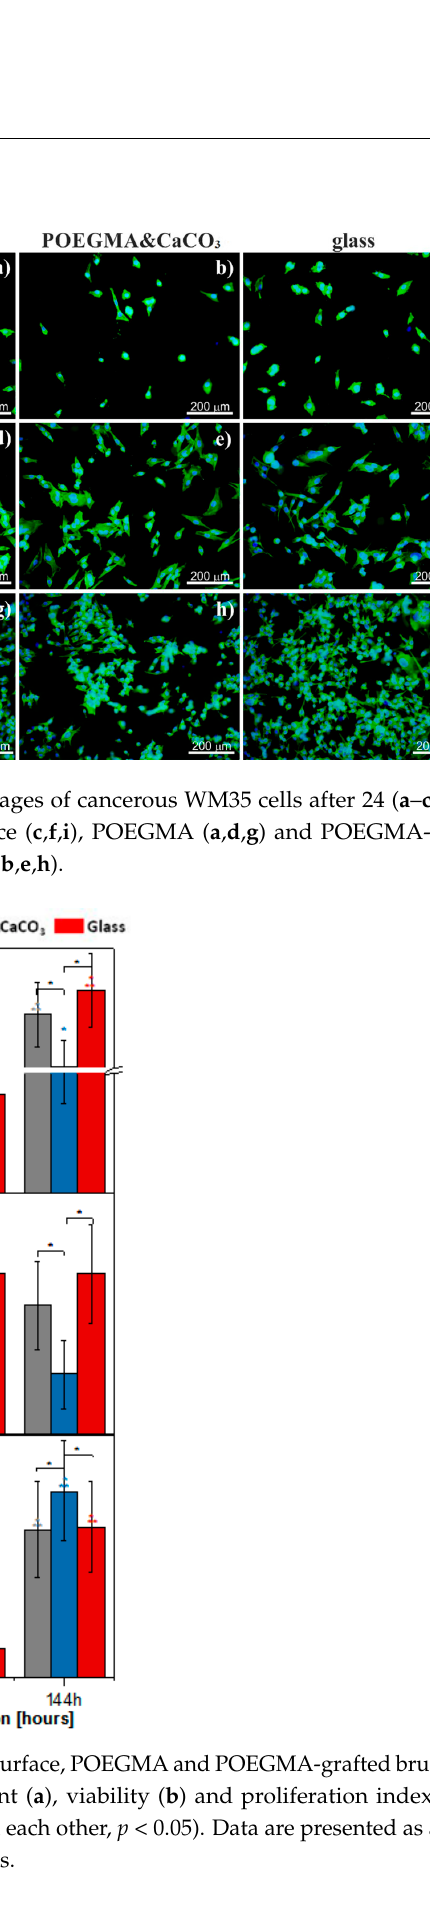
Figure 11. Fluorescence images of osteoblastic cell line MC3T3-e1 (Calcein AM) after 24 ( a – c ), 72 ( d – f ) and 144 h ( g – i ) of cultivation on glass surface ( c , f , i ), POEGMA ( a , d , g ) and POEGMA-grafted brush coatings with incorporated CaCO 3 NPs ( b , e , h ).